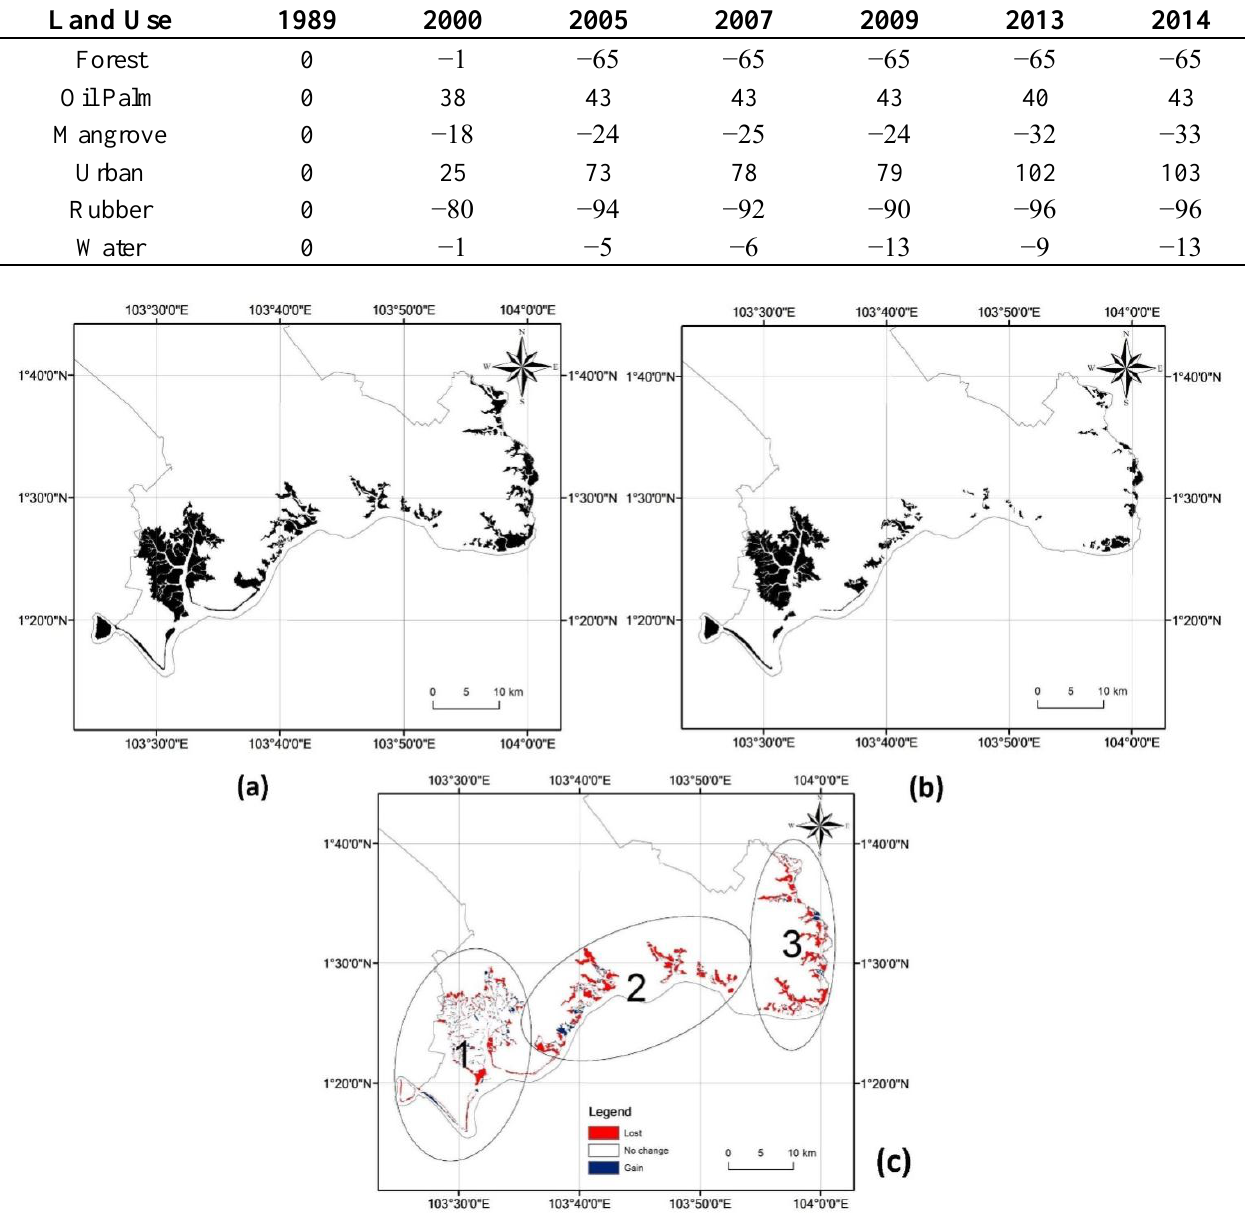
Figure 8. Mangrove cover changes between 1989 and 2014 ( a ) mangrove cover in 1989; ( b ) mangrove cover in 2014; and ( c ) loss and gain of mangrove between 1989 and 2014. The three major mangrove areas are circled and numbered as 1, 2 and 3. Refer to Table 5 for the mangrove